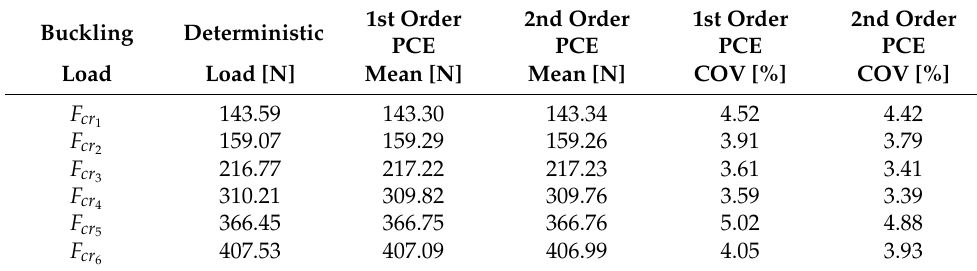
Table 10. Case 1 critical buckling loads mean value and COV calculated by means of first- and second-order PCE considering spatially varying fibre volume fraction and fibre